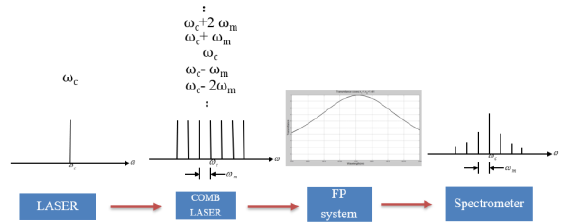
Figure 6 Numerical simulation results of solid state etalon transmittance curves